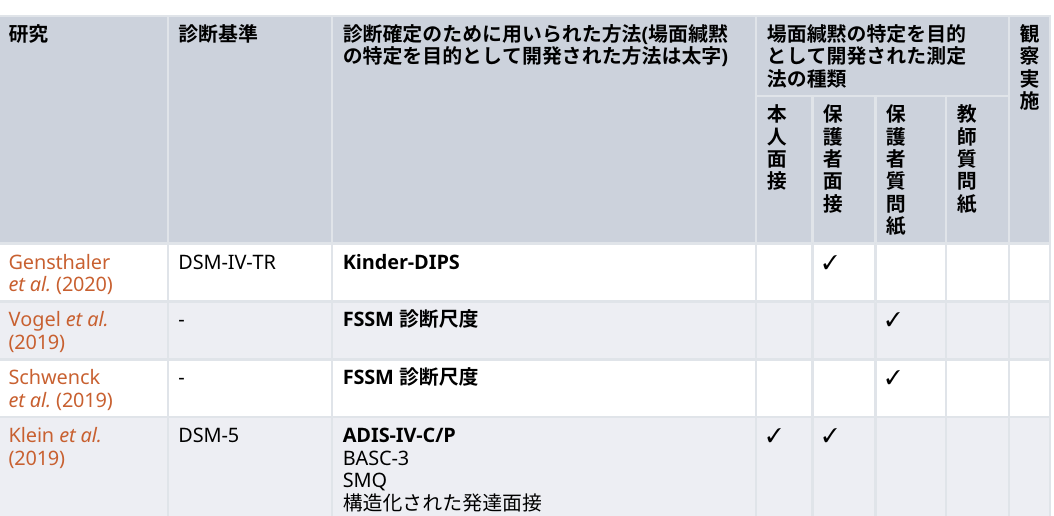
Table 2. 場 面 緘 黙 診 断 確 定 に 用 いられた 手 法